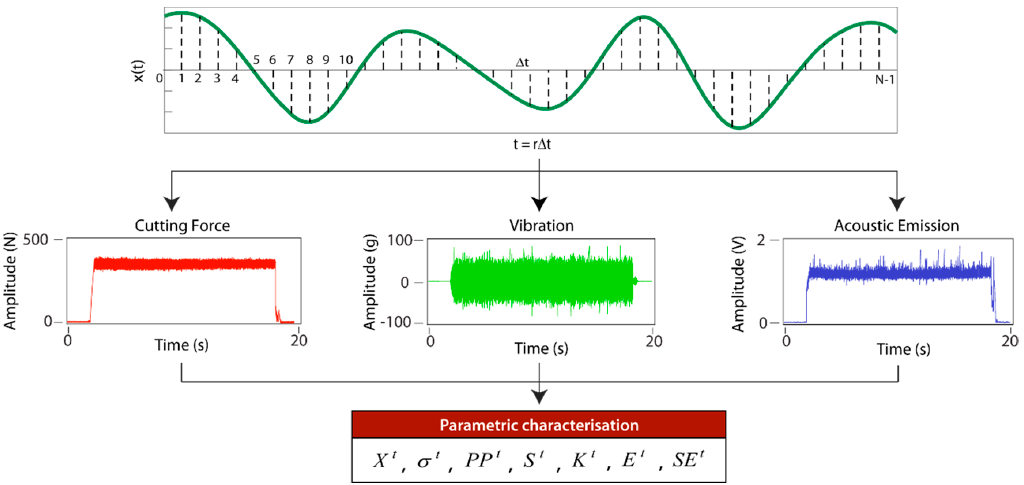
Figure 3. Time direct analysis signal processing method.